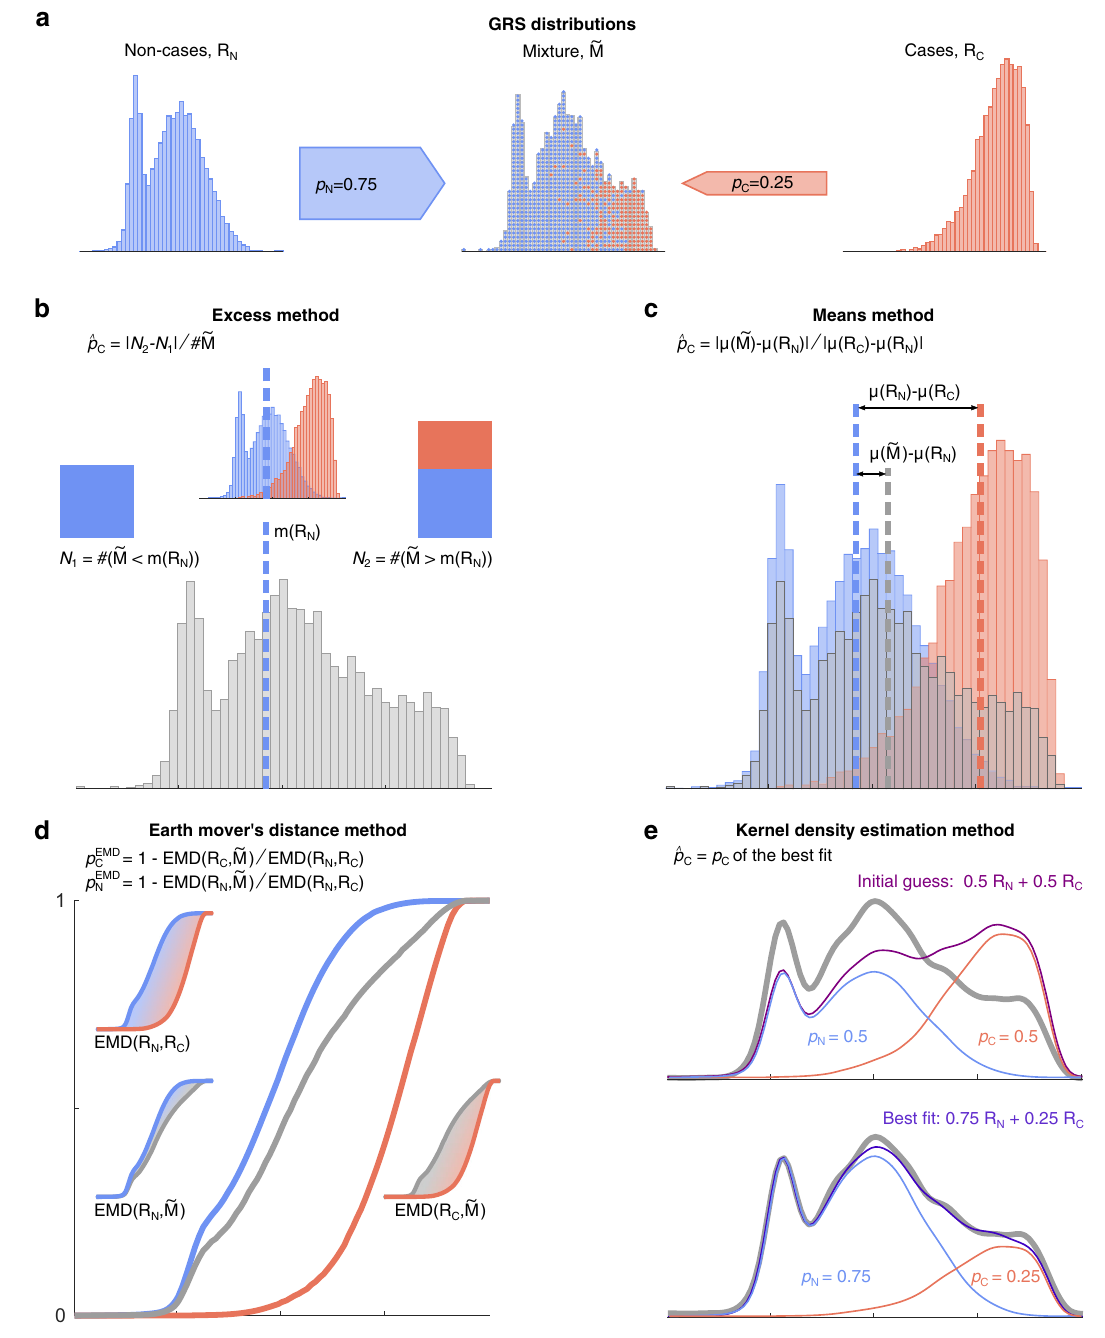
Fig. 1 Illustration of a mixture population drawn from two reference populations and the four proportion estimation methods. a This mixture population emulates the real-world scenario of a population composed solely of individuals drawn from each subpopulation of non-cases (R N , blue) and cases (R C , red). Mixture ( e M) cohort possesses features of both reference cohorts. Each method uses different characteristics of the mixture and reference cohorts to estimate the proportion of constituents of the mixture cohort ( p C and p N ). The Excess method ( b ) considers the number of cases above the mixture median in excess of those expected in a pure control (non-cases) reference cohort. The Means method ( c ) uses the normalised difference of the mixture cohort ’ s mean and the two reference cohorts ’ means. The Earth Mover ’ s Distance method ( d ) uses the weighted costs of transforming the mixture distribution into the reference distributions. The Kernel Density Estimation method ( e ) fi ts smoothed templates to each of the reference distributions and then fi ts a weighted sum of these templates to the mixture distribution, adjusting the amplitudes of each with the Levenberg – Marquardt algorithm. Figure generated using arti fi cial